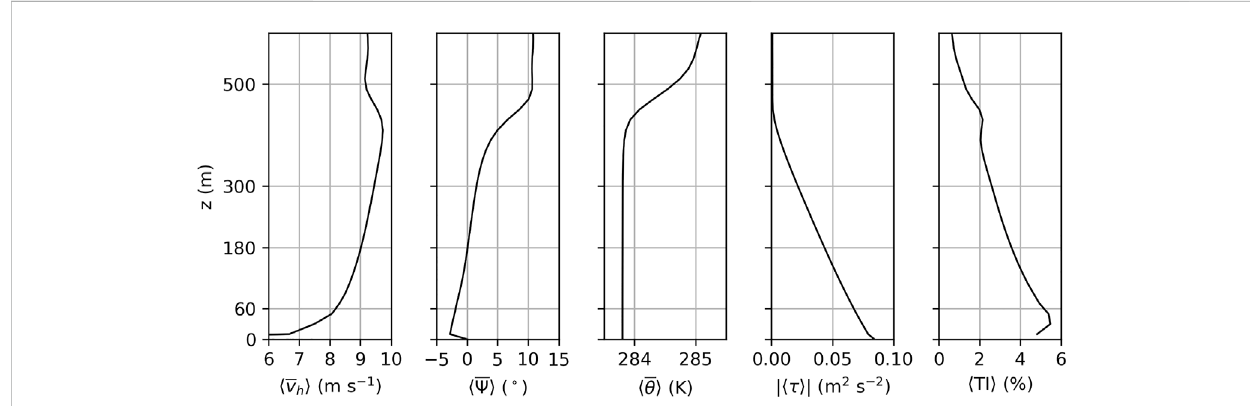
FIGURE 2 Verticalpro fi lesofthehorizontalwindspeed v h ,thewinddirection Ψ (clockwisepositive),thepotentialtemperature θ ,thekinematicmomentum fl ux τ and the turbulence intensity TI. The pro fi les are horizontally averaged ( 〈 (cid:129) 〉 ) over the entire precursor domain and temporally averaged ( (cid:2) (cid:129) ) over the last 4 h of the precursor simulation. Horizontal lines mark rotor bottom (60 m), hub height (180 m), rotor top (300 m) and inversion layer height (500